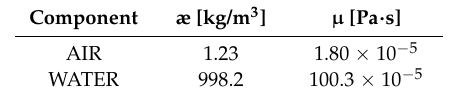
Figure 2. Three tested water free surfaces.